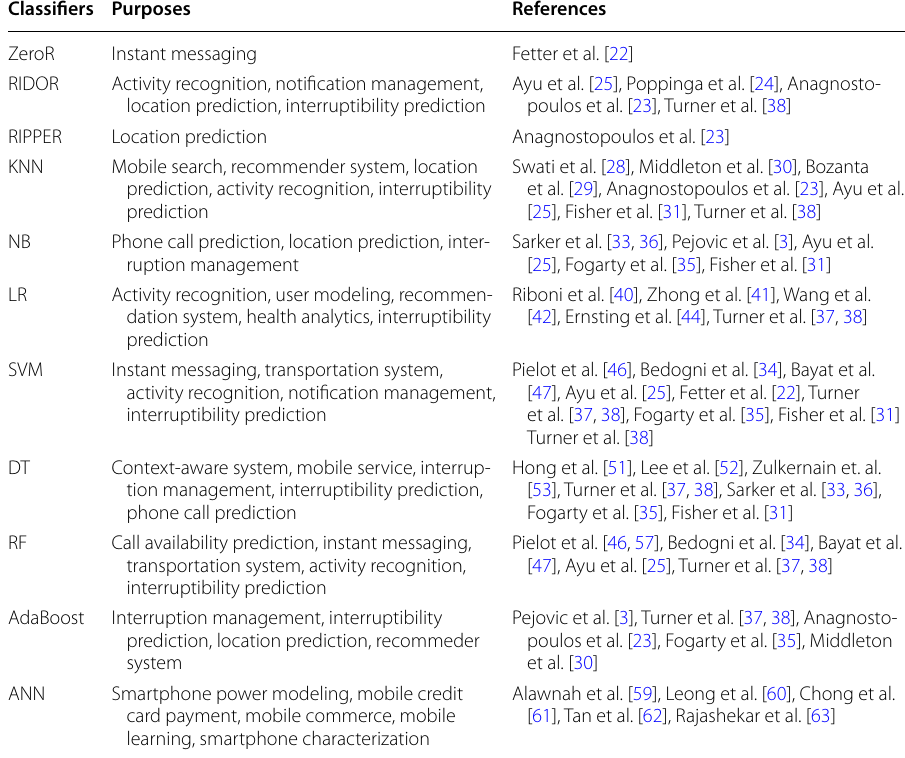
Table 1 A summary of machine learning classification techniques used for various context‑aware mobile services and